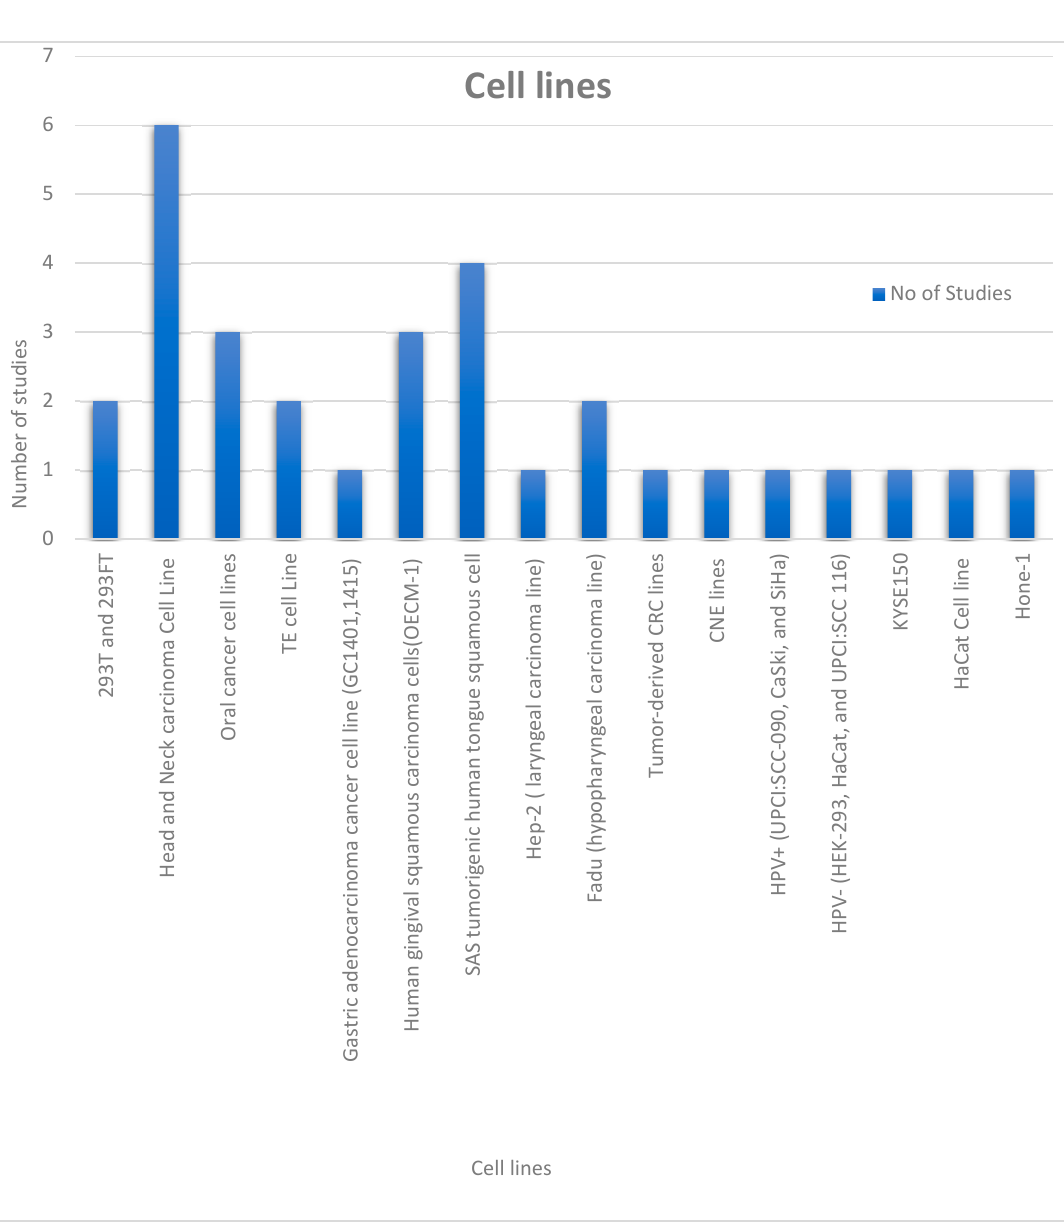
Figure 3. Chart showing the various cell lines utilized in the collected studies.